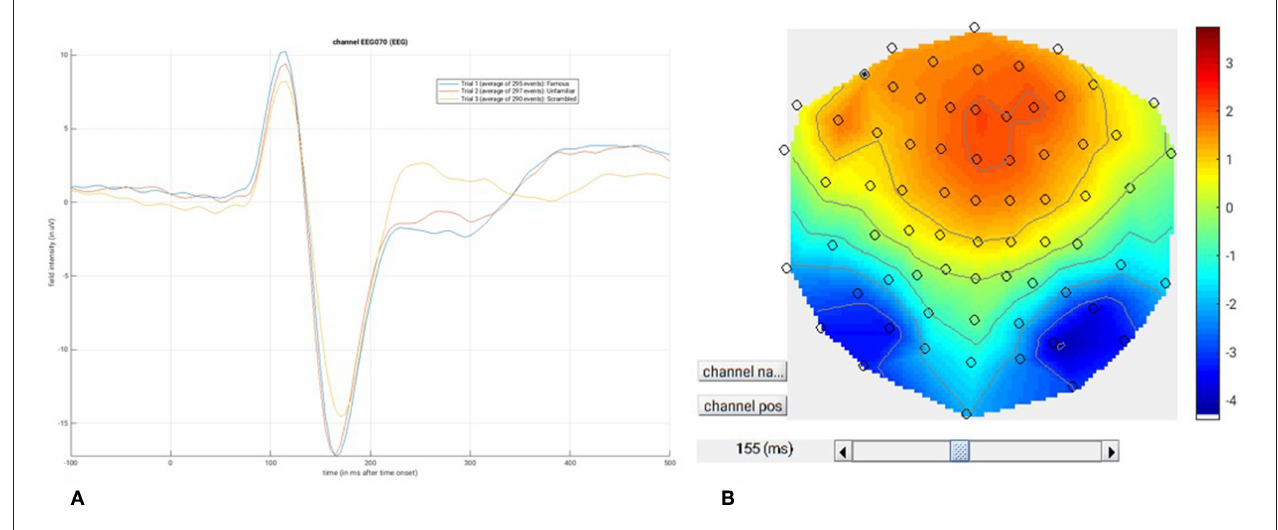
FIGURE 5 | (A) Single-channel ERP for each condition, (B) Topography for differential ERP for faces minus scrambled